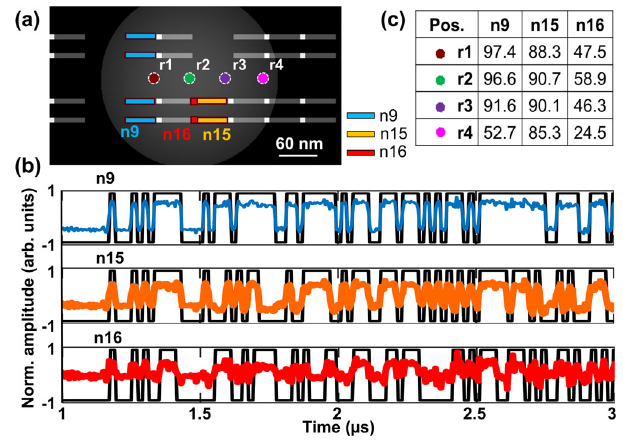
Fig. 3 | Signal extraction down to the gate level. a A section of the layout under observation. Four raw waveforms are collected from positions marked by circles (r1 – r4) . Nets n9, n15 , and n16 are collocated within the optic probe in each of the positions. b Graph showing extracted waveforms from n9, n15 , and n16 , from r2 overlaid with expected timing diagrams in black. c Table summary of the highest correlations (pcc) of each extracted net with its corresponding timing diagram showsthatthestrongestsignal-to-noiseratiooftheextractedsignalsisachievedon the largest physical net n9 , and occurs when the optic probe is positioned most accurately on the net (at r1 ). Remarkably, the signals from a gate net n16 which spans <200nm 2 in area can be extracted with a 58.9% correlation to the expected signal at r2 despite the optic probe spanning a lateral area >25,000nm 2